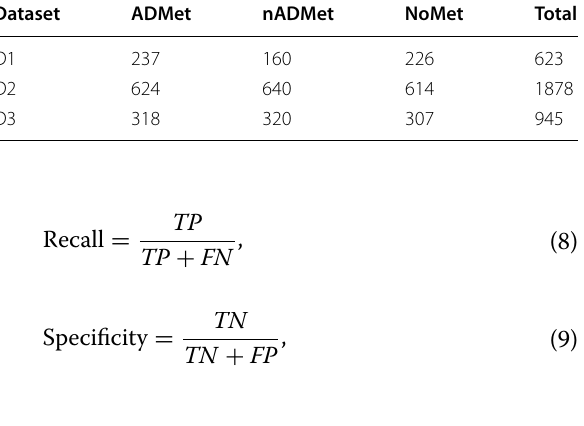
Table 2 An overview of the datasets used in this work